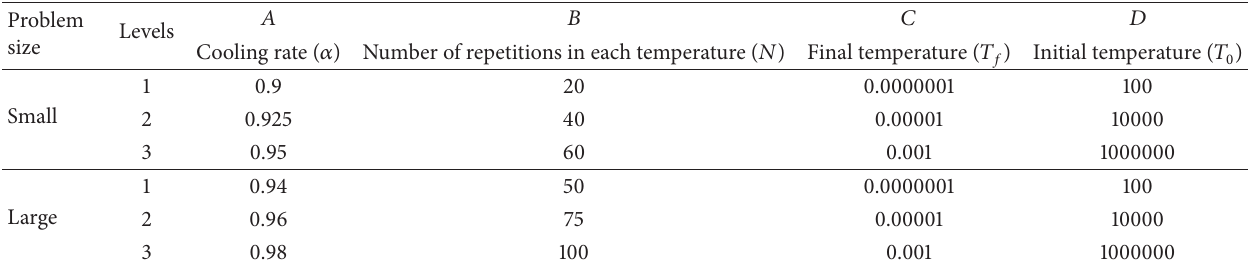
Figure 3: Genetic algorithm flowchart. Table 1: Simulated annealing algorithm parameters and their